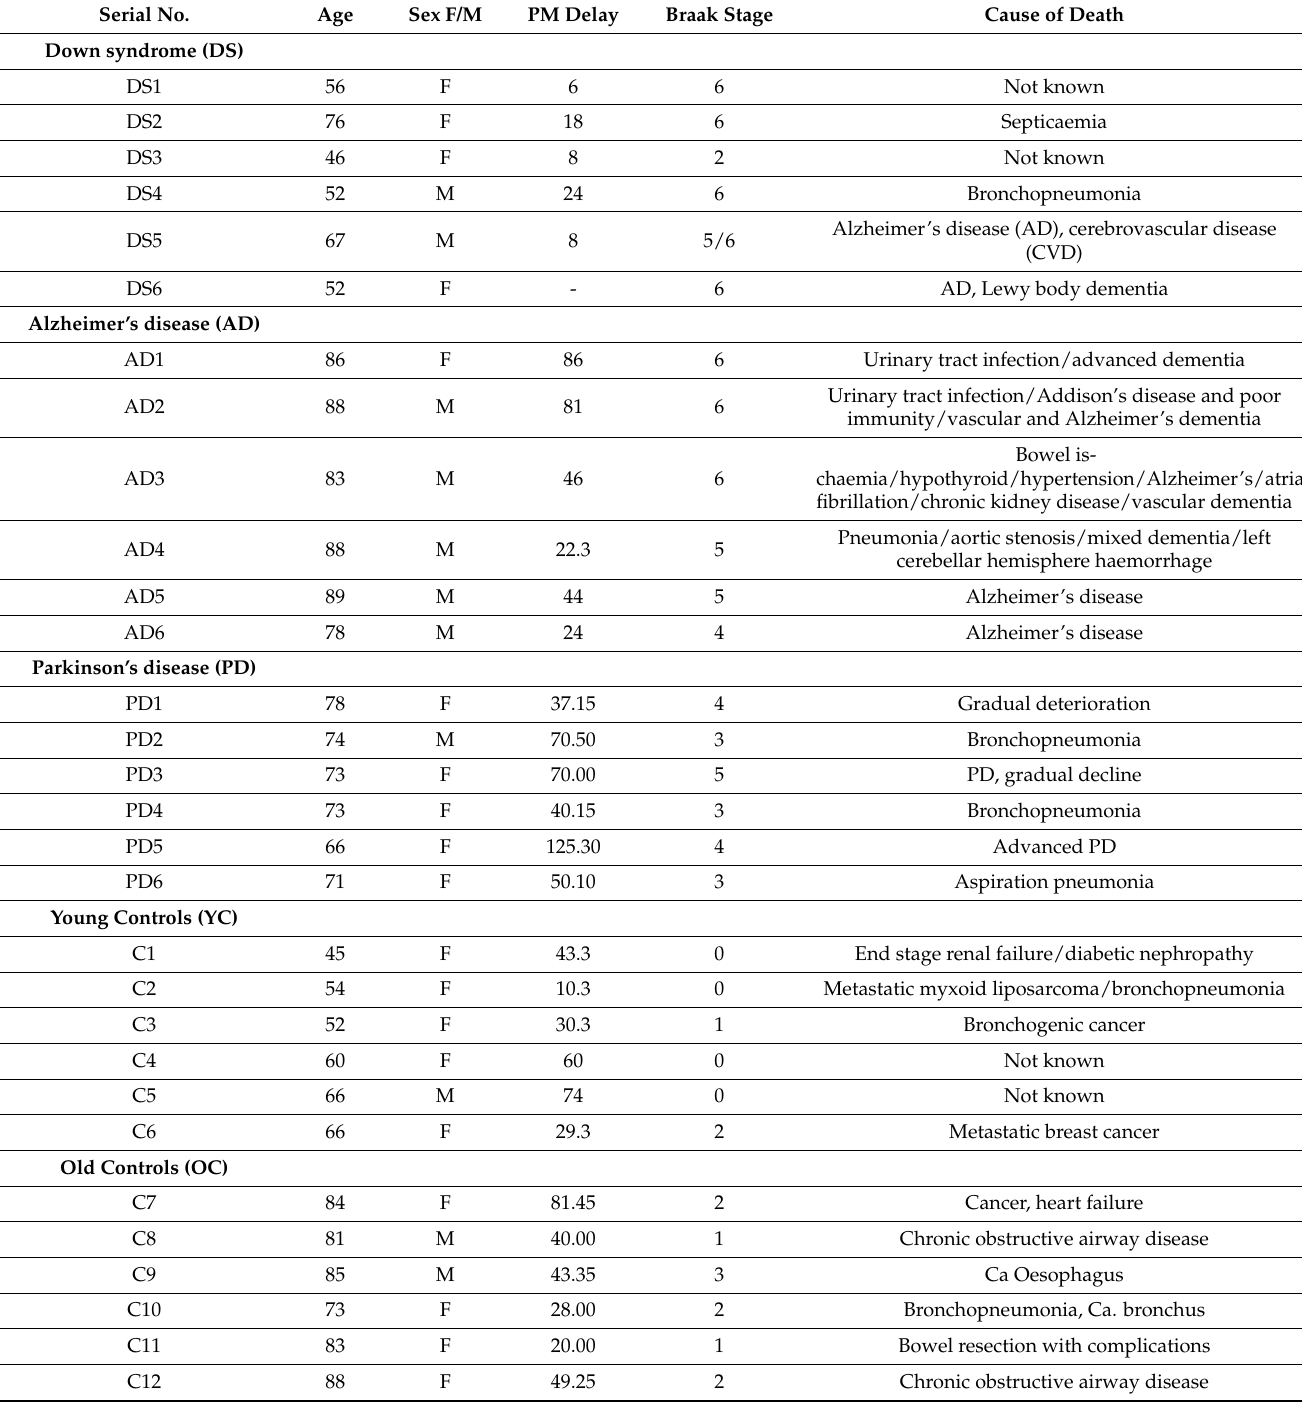
Table 1. Brain sections from Down syndrome, Alzheimer’s disease, Parkinson’s disease, and age- matched controls